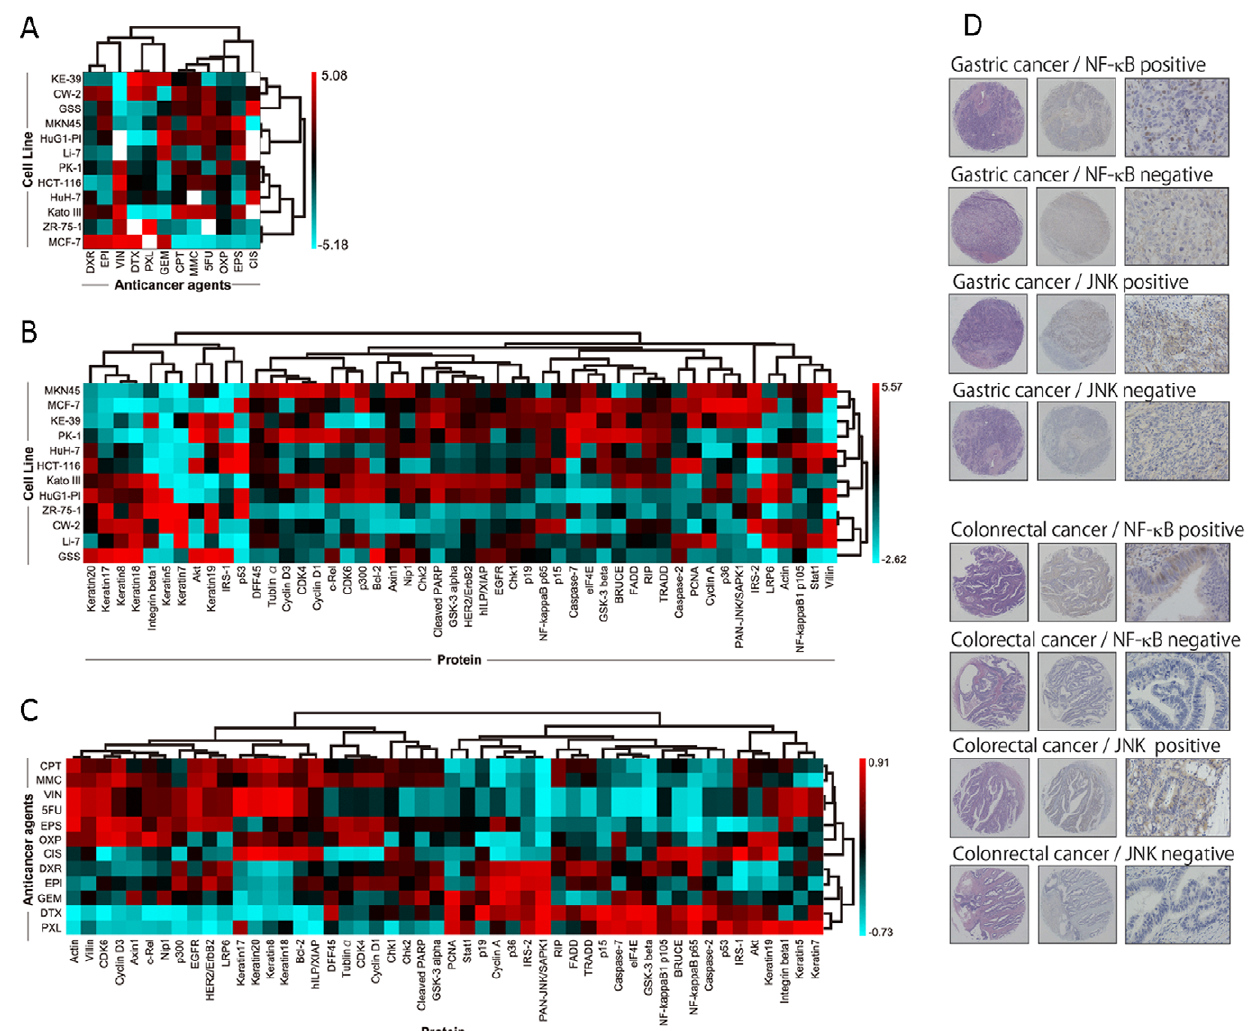
Figure 1. Hierarchical clustering of three different matrices and results of immunohistochemical examinations of candidate markers. (A) Based on a chemosensitivity assay of a cancer cell line panel, the A (activity) 6 C (cells) = AC matrix was created. (B) Quantitative protein expression data of each cell line determined by ‘‘reverse-phase’’ lysate microarray generates the C 6 P (protein) = CP matrix. (C) A heatmap with hierarchical clustering representation of the AP matrix, which is generated from AC and CP matrices. (D) Immunohistochemical stainings of candidate markers for 5-FU treatment.